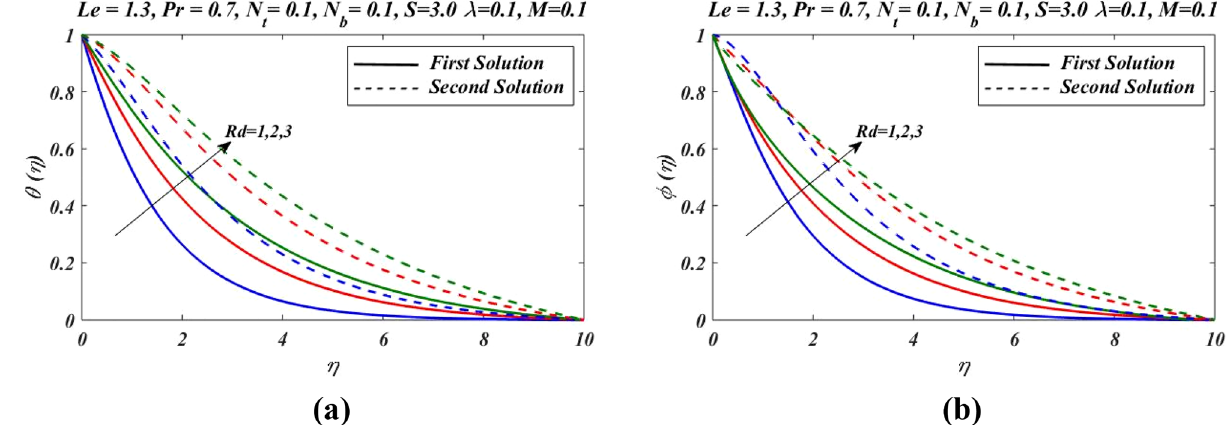
Figure 7. Outcomes of Rd on ( a ) temperature and ( b ) nanoparticles volume fraction.